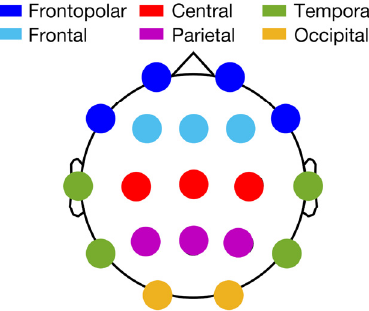
Figure 1. EEG clusters for correlational analysis with MR data, with EEG electrodes subdivided into 6 topographical clusters according to their location on the scalp. Frontopolar cluster: Fp1, Fp2, F7, F8 (dark blue); frontal cluster: F3, F4, Fz (light blue); central cluster: C3, C4, Cz (red), parietal cluster: P3, P4, Pz (purple); temporal cluster: T3, T4, T5, T6 (green); occipital cluster: O1, O2